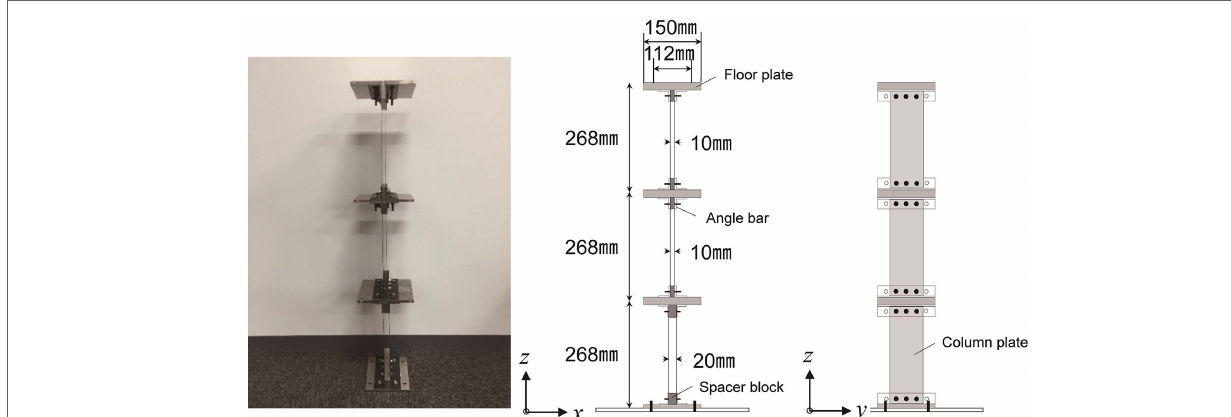
FIGURE 11 | Photograph and diagram of scaled structure.